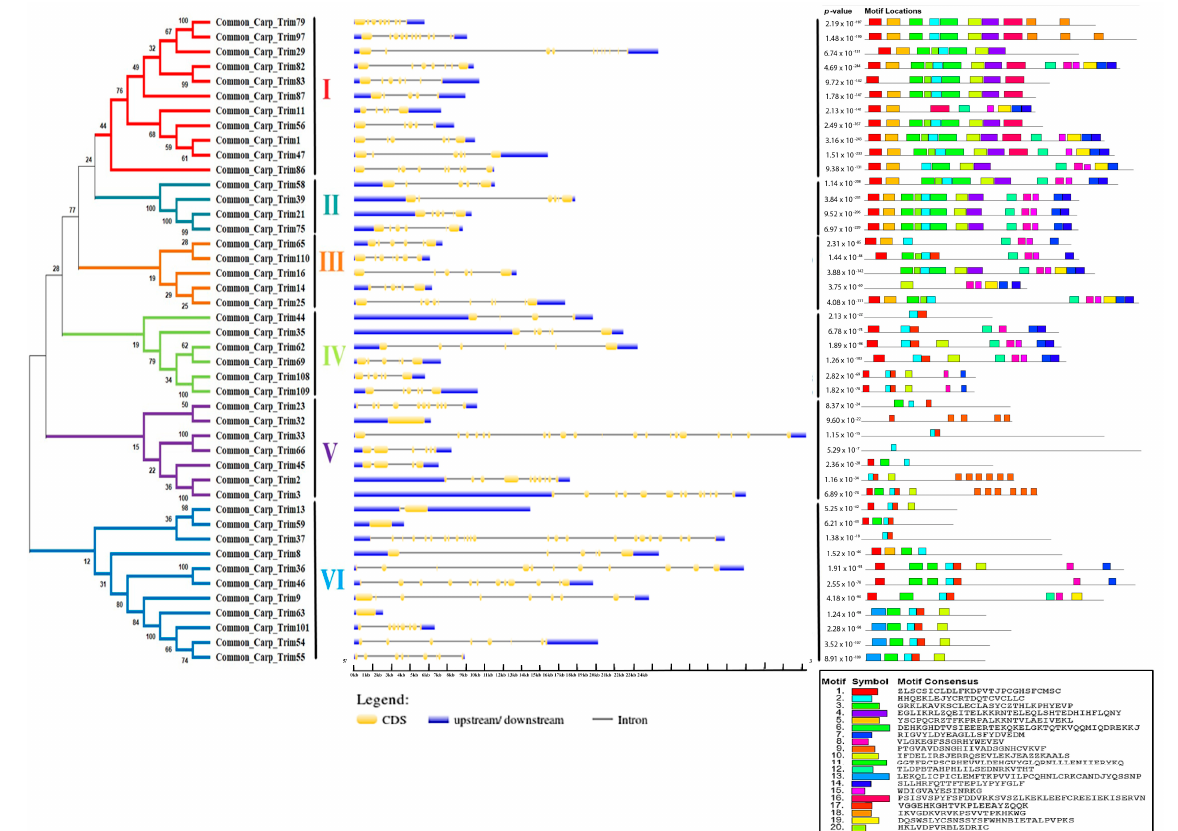
Figure 3. Phylogenetic relationship, gene structure, and motif composition of TRIM family in common carp. The phylogenetic tree of CcTrim proteins were classified into six groups based on clusters generated through phylogenetic analysis. Each cluster is marked with different color and designated as cluster 1–6. Next the blue color represents 5 and 3 prime end untranslated region, the black lines show introns and the yellow color represents exons of genes. Moreover, motif composition of the CcTrim proteins elucidated twenty different motifs that are presented in a color box having specific amino acid pattern. The black line represents non-conserved sequences. At the bottom, the unique color symbol of motifs 1 to 20 with consensus sequence is shown.